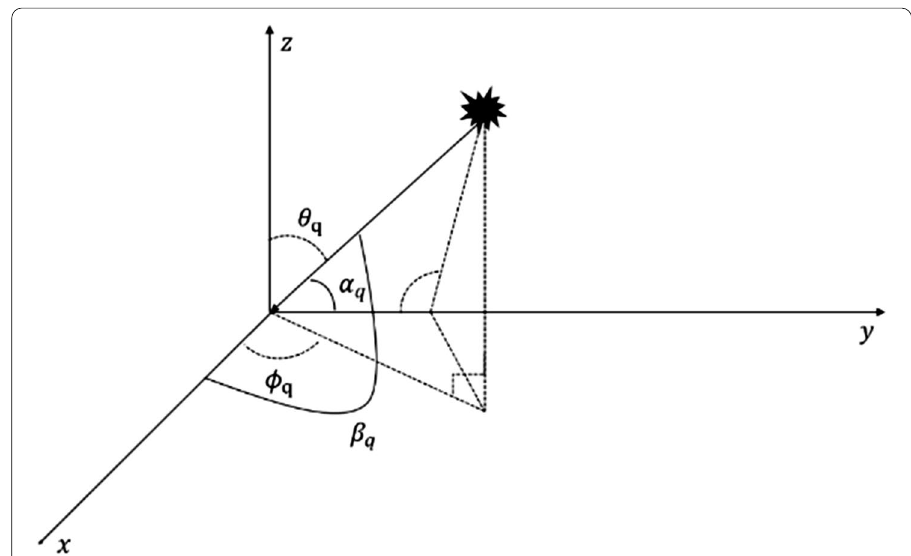
Fig. 4 (θ q , φ q ) and (α q , β q ) relationship